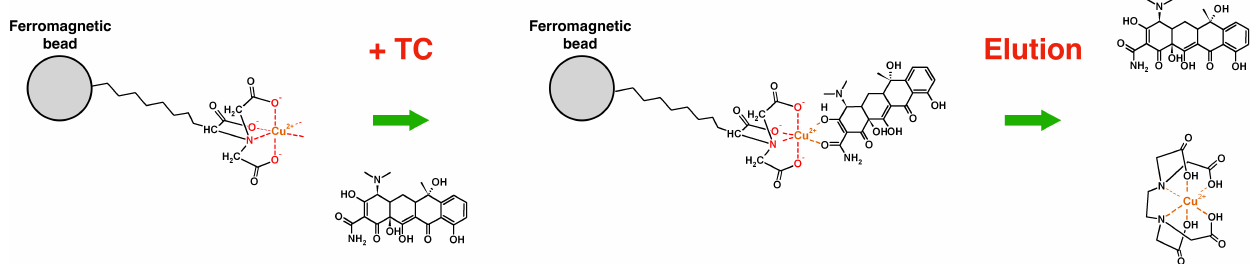
Figure 2. Scheme of the purification principle. Tetracycline binds the two free coordination sites of copper ions present on the surface of magnetic beads. When an acidic buffer containing EDTA is added, copper ions coordinate the EDTA molecules and tetracycline is